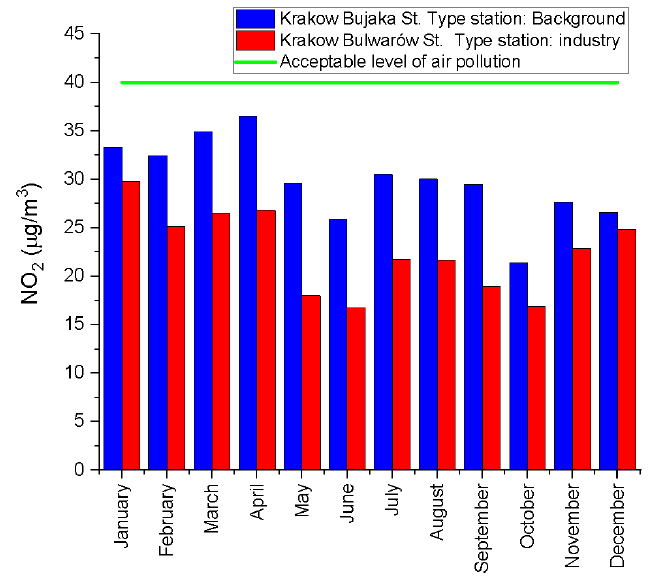
Figure 12. Average NO 2 concentration in individual months of 2020.